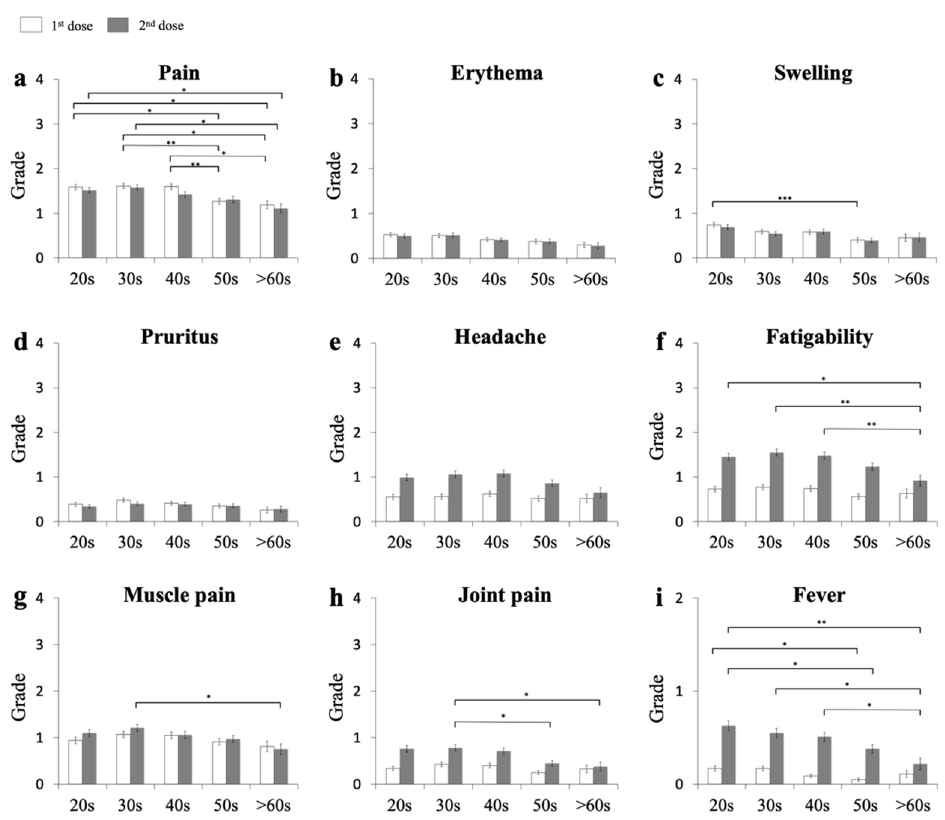
Figure 1. Local and systemic adverse reactions upon receiving first and second dose of vaccine in individuals in each 10-year age group. Local ( a – d ) and systemic ( e – i ) reactions are shown. Open bars represent the mean ± SE after the first dose and closed bars represent the mean ± SE after the second dose. * p < 0.05, ** p < 0.01, *** p < 0.001.